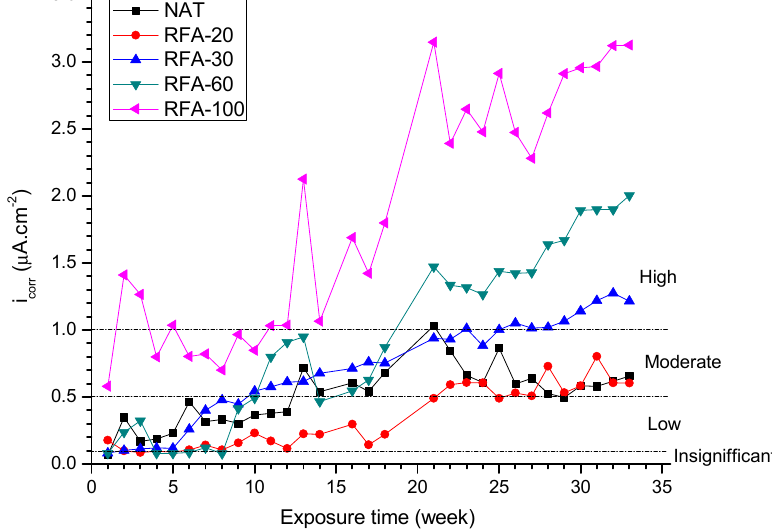
Figure 11. Evolution of i corr for mixtures with RFA.